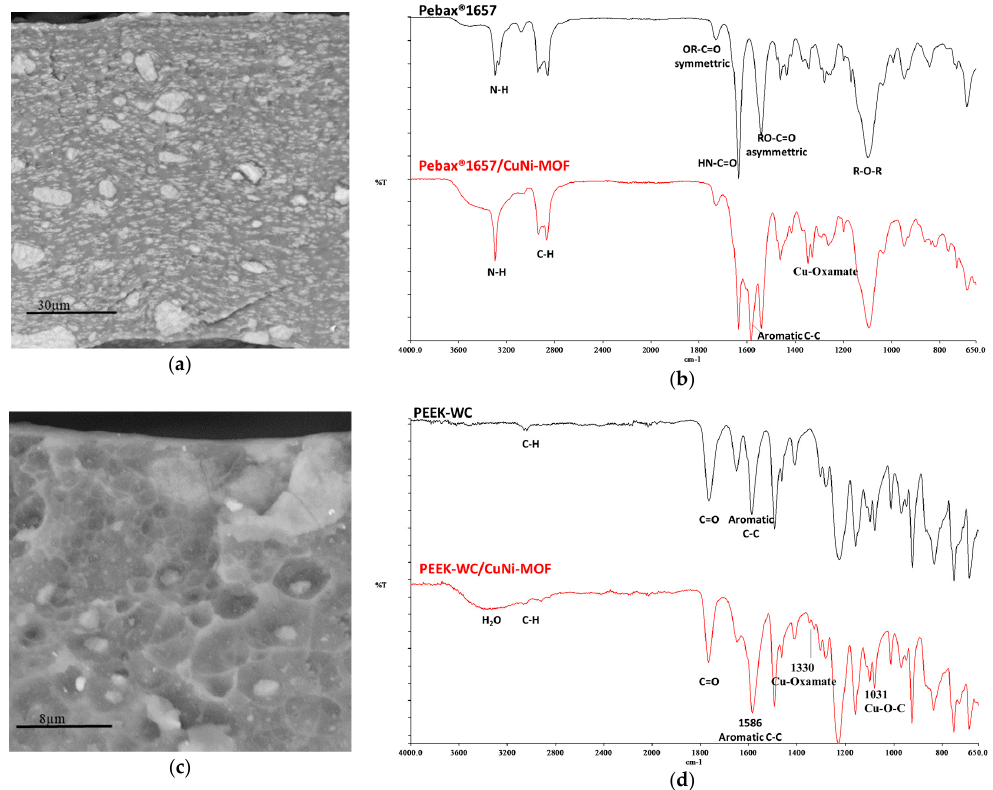
Figure 2. SEM image of the samples showing the interface between MOF and polymer phase ( a ) for Pebax ® 1657 and ( c ) PEEK-WC. FT-IR of neat polymer and MMMs with 23 wt % of CuNi, for Pebax ® 1657 ( b ) and PEEK-WC ( d ).